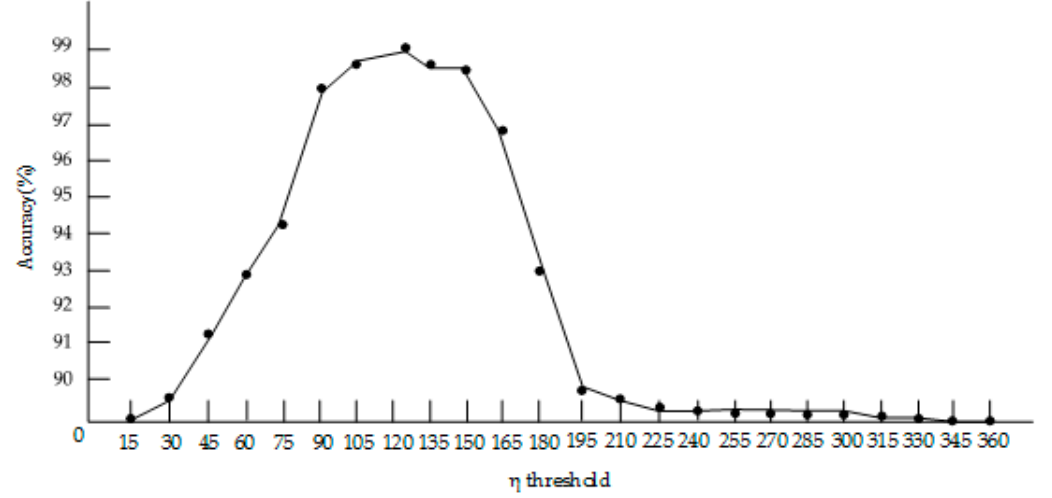
Remote Sens. 2020 , 12 , x FOR PEER REVIEW Figure 13. Setting of the constraint threshold of image value η . Figure 13. Setting of the constraint threshold of image value η .